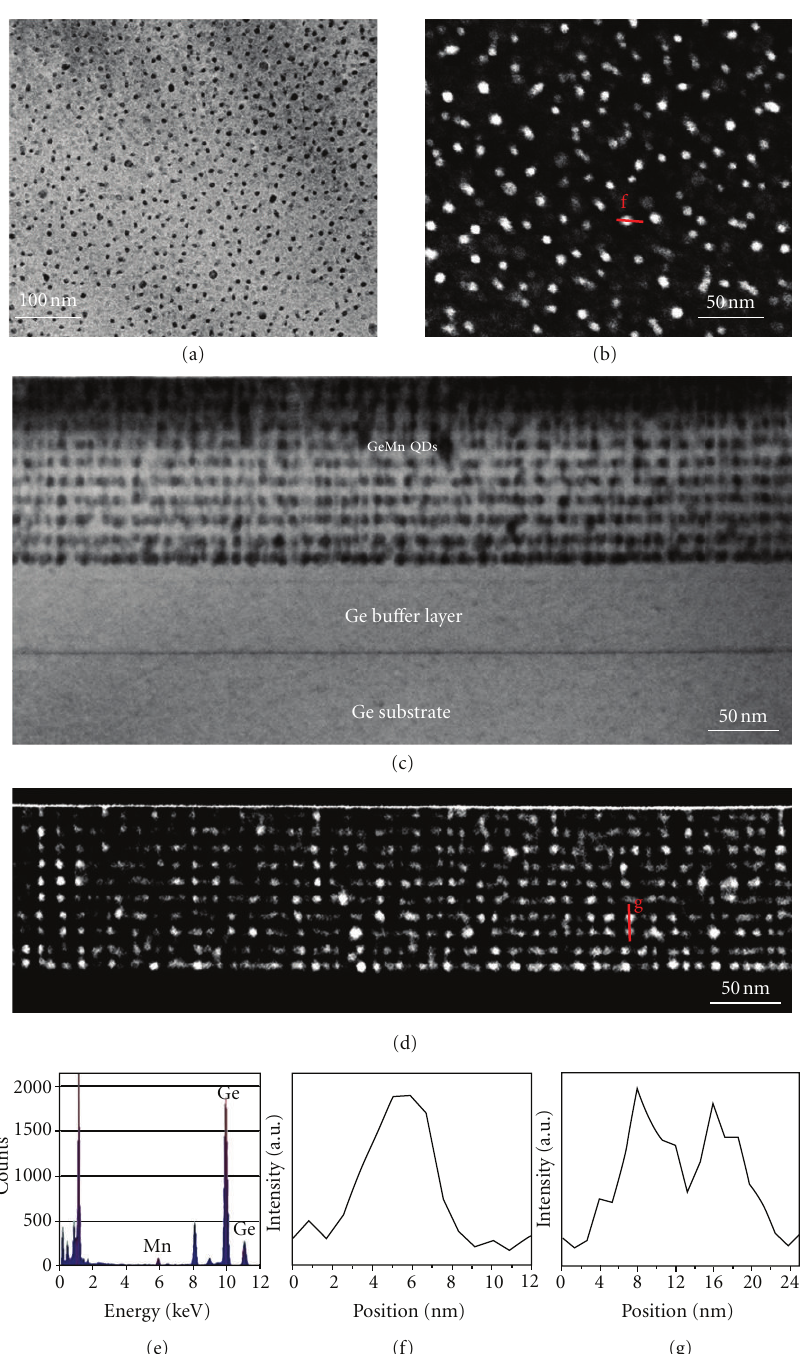
Figure 15: (a) A plane-view bright-field TEM image of MnGe nanodots (dark spots). (b) A plane-view low-angle dark-field STEM image of the MnGe nanodots (white spots). (c) A cross-sectional TEM image of the MnGe nanodot arrays (dark spot arrays). (d) A cross-section STEM image of the MnGe nanodot arrays (white spot arrays). (e) An EDS profile showing the Mn and Ge peaks. ((f), (g)) EDS line-scan profiles of the line marked in (b) and (e) using Mn K peak, respectively. Reproduced from [19]. Copyright ©2011 Wang et al.; licensee Springer